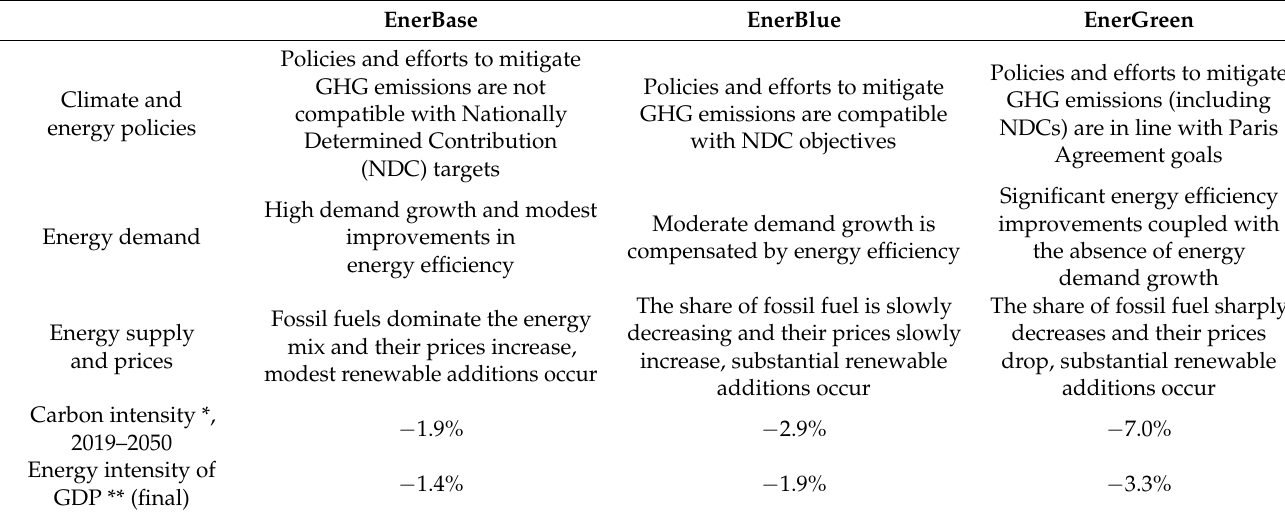
Table 1. Energy and decarbonization the CIS scenario